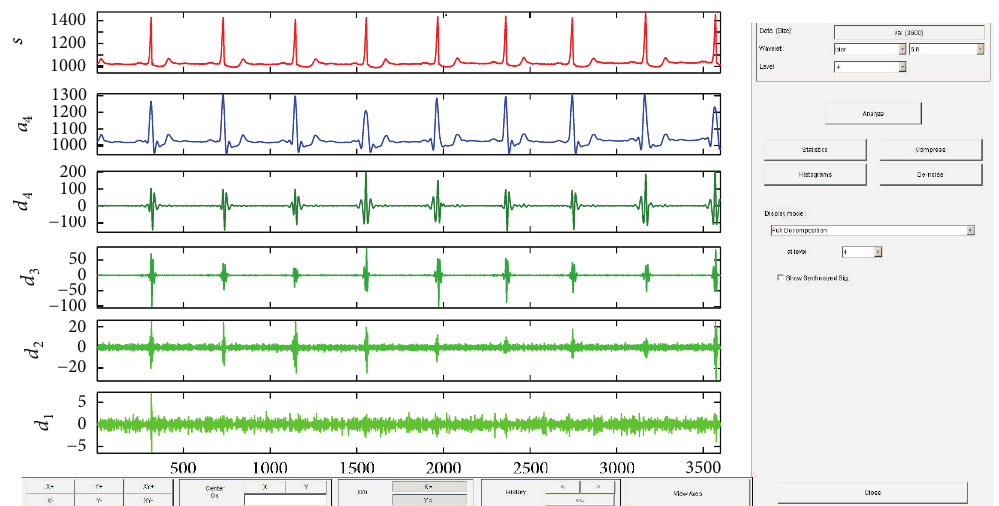
Figure 4: Wavelet denoising for ECG record no 114m using Biorthogonal 1D wavelet.